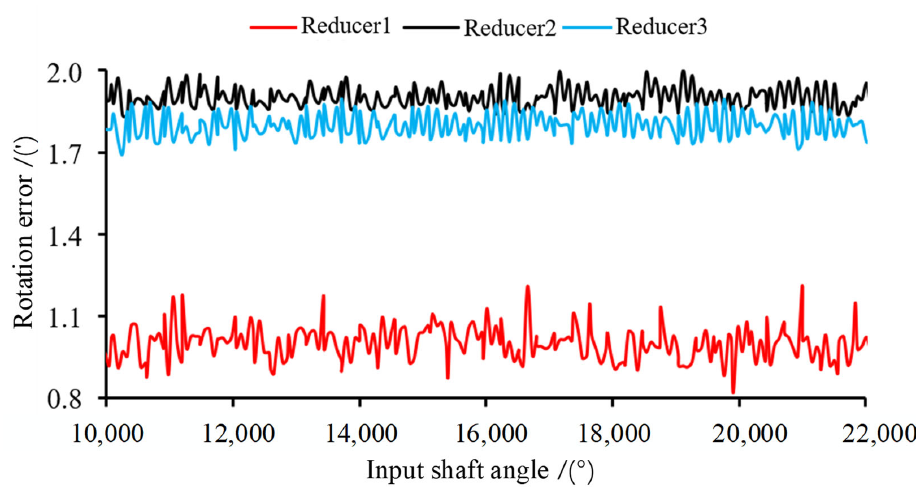
Figure 3. Test curve chart for reducers.